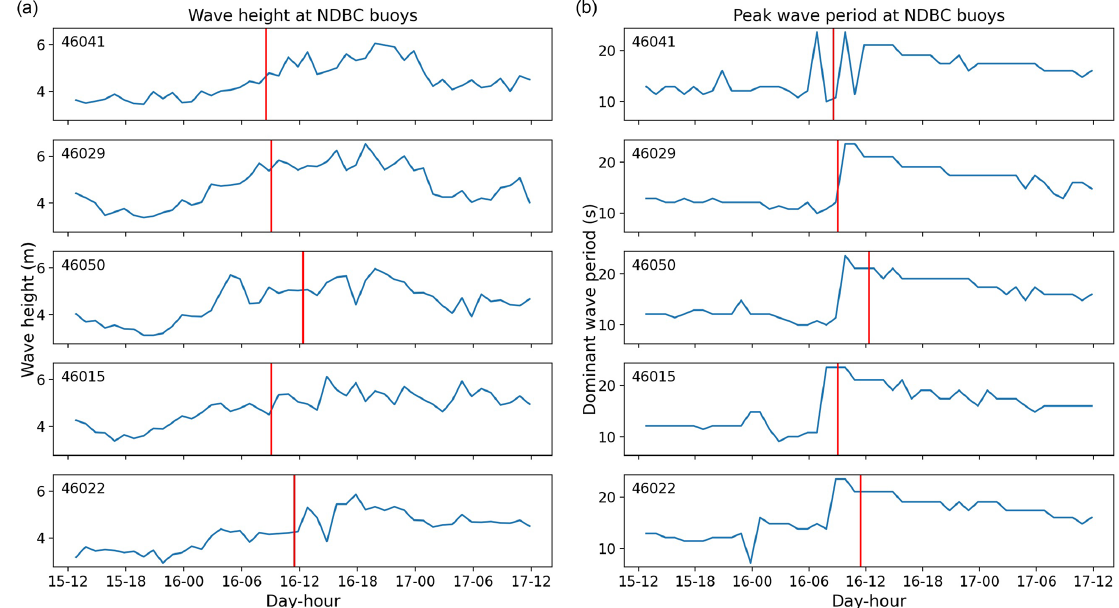
Figure 8. Significant wave height (a) and peak wave period (b) at NDBC buoys (ordered north to south from top to bottom) from 15 January, 12:00, to 17 January, 12:00, in 2016. Data are recorded at 1h intervals. Vertical red lines represent 08:33, 09:03, 12:21, 09:03, and 11:27 on 16 January from top to bottom, i.e., the approximate onset of unusual water level fluctuations at the nearby tide gages.